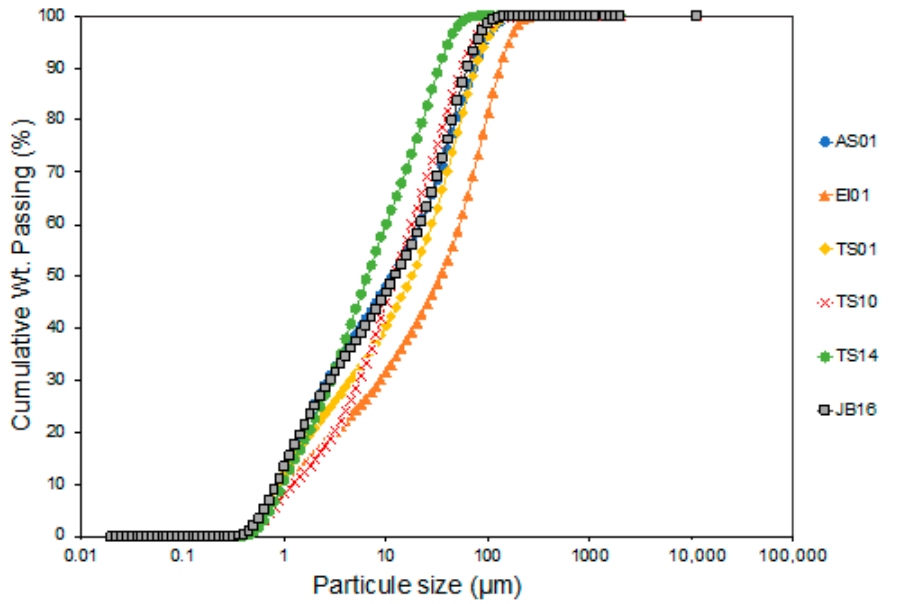
Figure 8. Particle size distributions of the studied samples.